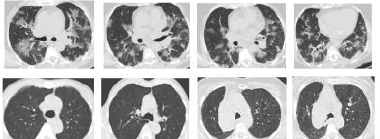
EAI Endorsed Transactions on e-Learning 08 2021 - 06 2022 | Volume 7 | Issue 23 |